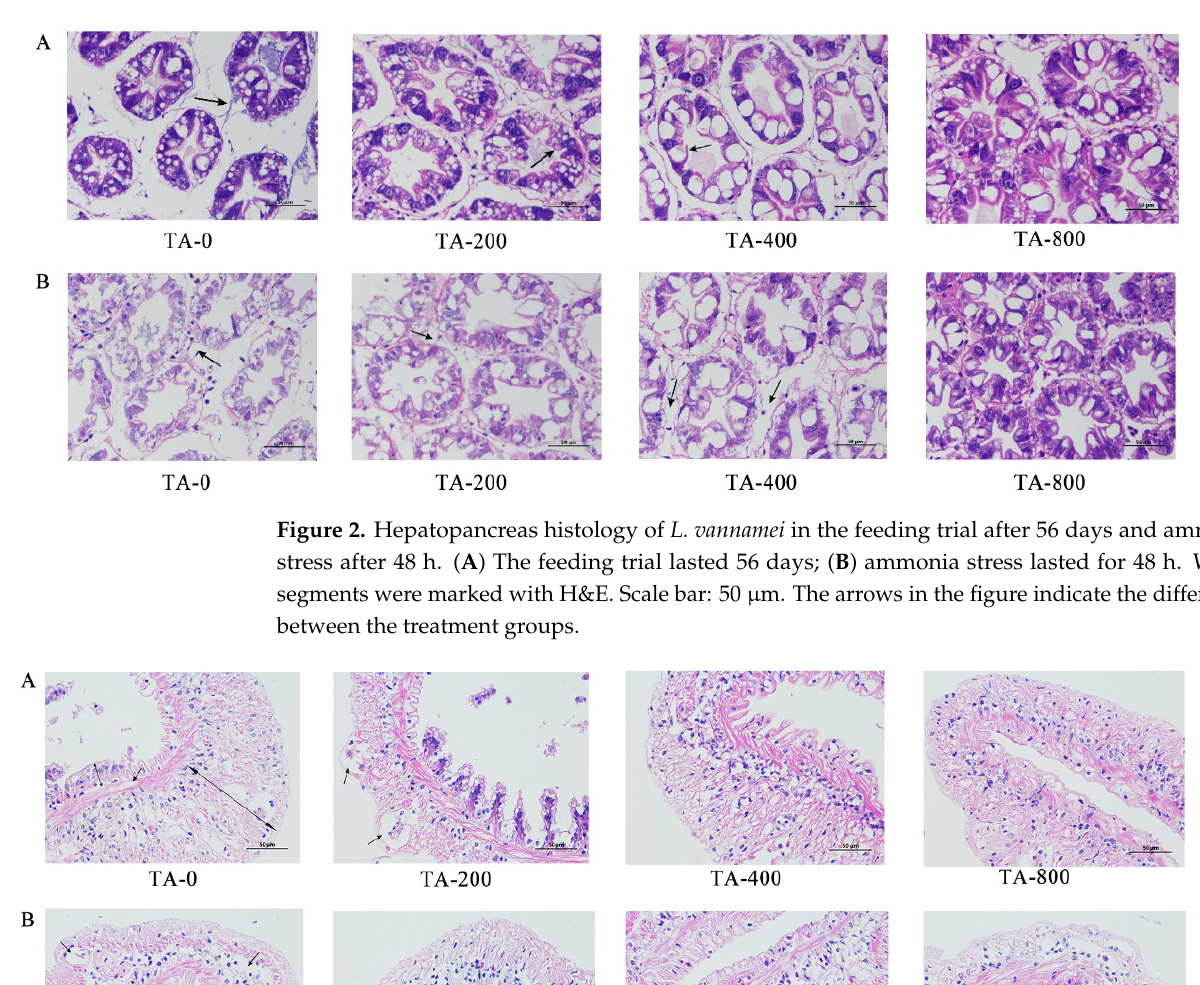
Figure 2. Hepatopancreas histology of L. vannamei in the feeding trial after 56 days and ammonia stress after 48 h. ( A ) The feeding trial lasted 56 days; ( B ) ammonia stress lasted for 48 h. Whole segments were marked with H&E. Scale bar: 50 μ m. The arrows in the figure indicate the differences between the treatment groups.